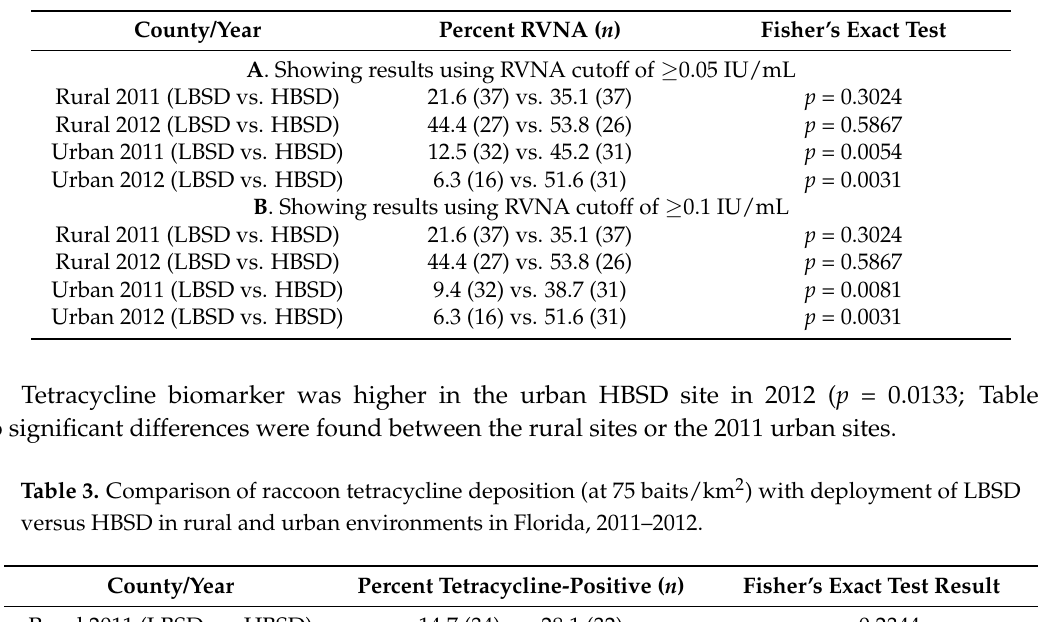
Table 2. Comparison of raccoon RVNA (at 75 baits/km 2 ) with deployment of LBSD versus HBSD in rural and urban environments in Florida, 2011–2012.